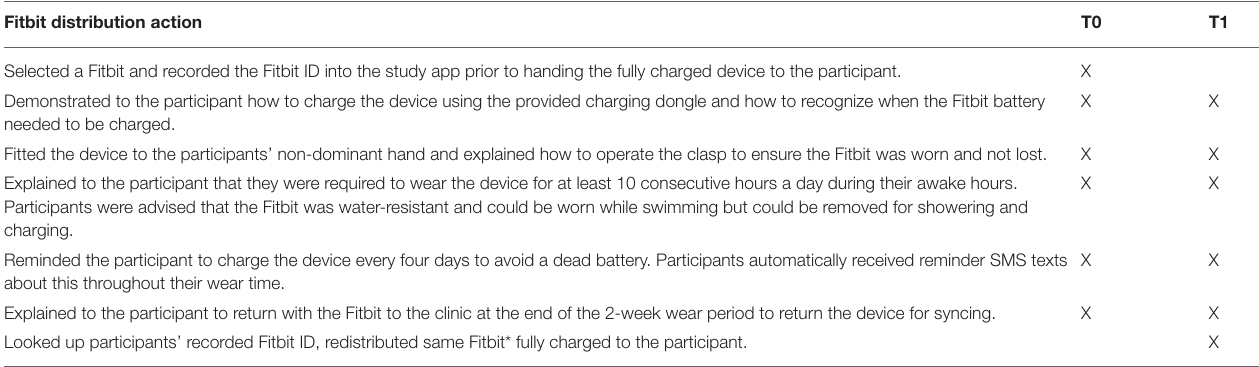
TABLE 2 | BHC fitbit distribution protocol for 2-week wear